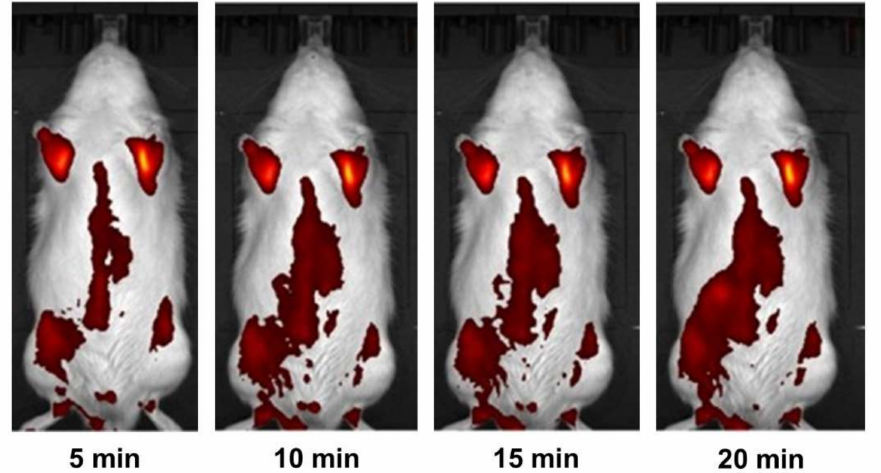
Figure 11. Time study of intravenous drug administration using fluorescence tomography (back- ground, BKG subtracted).